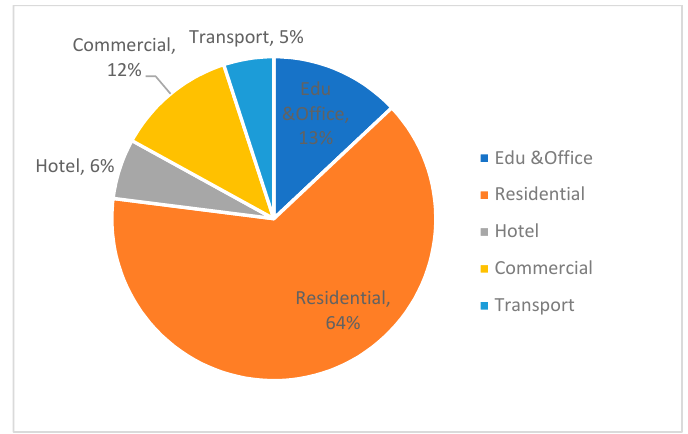
Figure 7. Proportion of building types in the areas for the study. Table 4. Built-up area of individual block zone. Land Zone